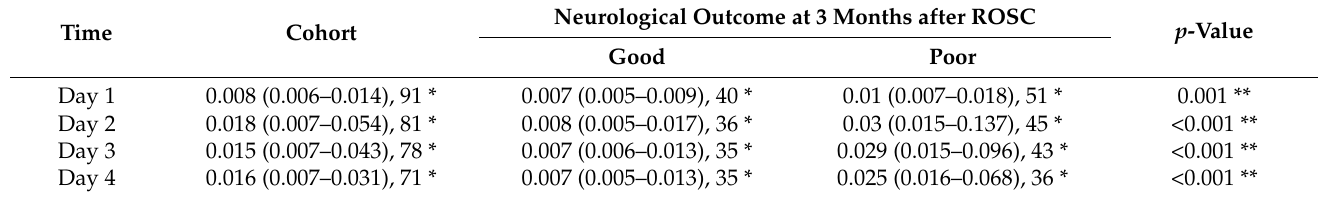
Table 3. A comparison of Q A values between neurological outcome